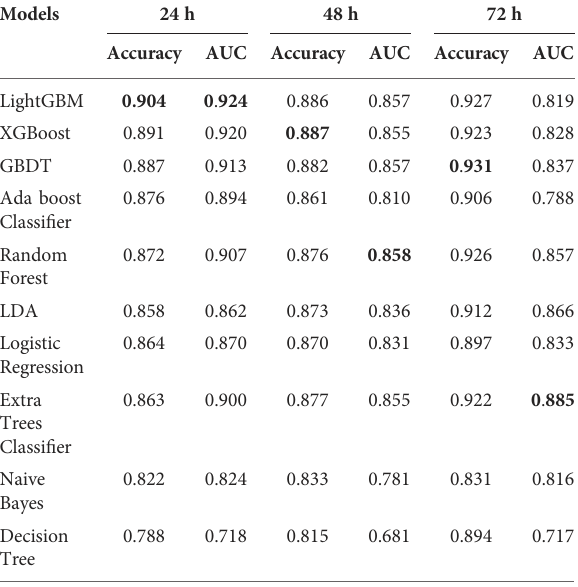
TABLE 1 Internal validation performance of various models.